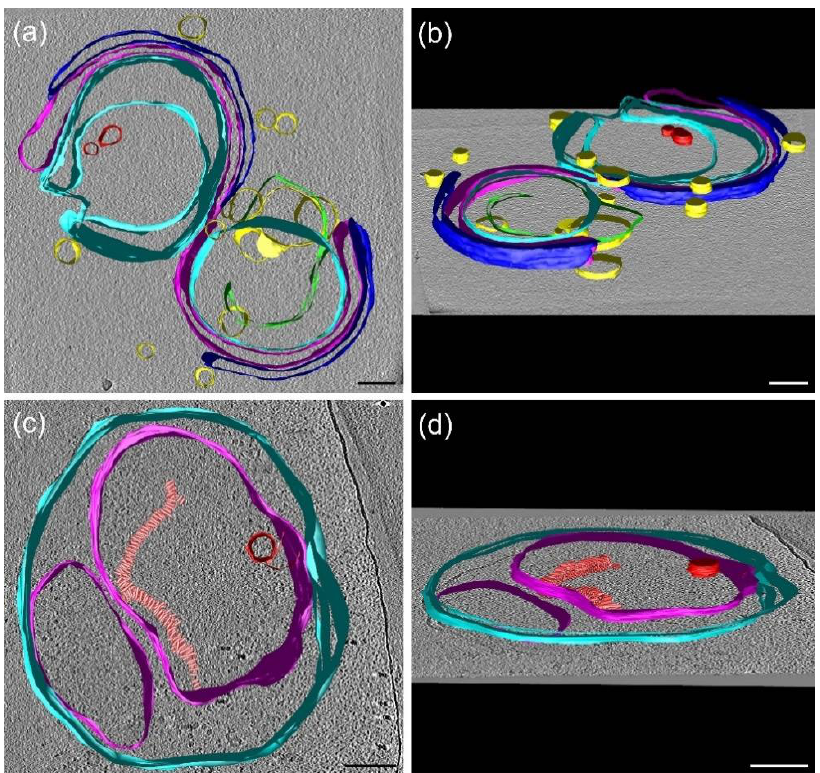
Figure 7. Surface views of reconstructed tomograms of granum and stroma thylakoid membranes. Panels ( a , c ) represent the top views of the granum and stroma thylakoid membranes, respectively. Panels ( b , d ) represent their corresponding tilted views. Cross-sections of the membranes of individual thylakoids, which are perpendicular to the X-Y image plane, are marked in cyan, magenta, and blue, small membrane vesicles are depicted in yellow. Membrane vesicles, which are inside the thylakoids, are shown in red. A tubular assembly in the stromal thylakoid membrane ( c , d , in salmon) is supposedly formed by lipids in the H II phase. Scale bars, 50 nm.